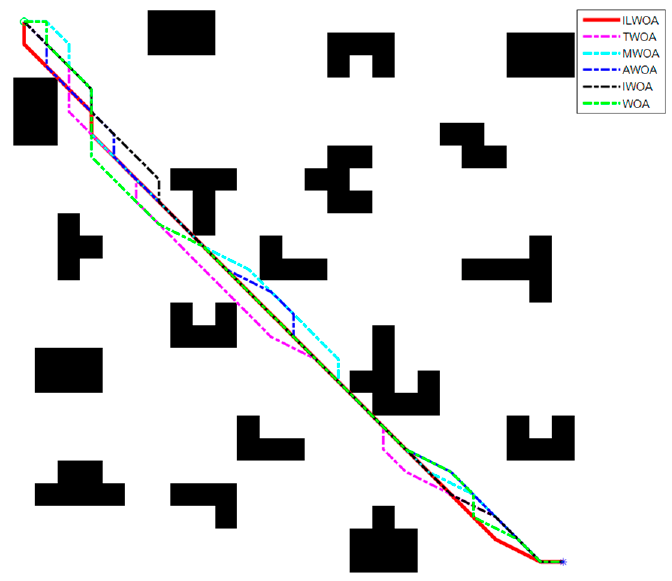
Figure 11. Robot path planning in Environment 2 scenarios .